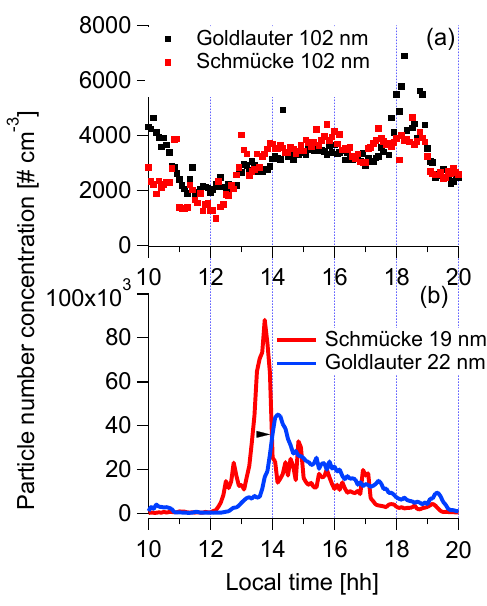
Fig. 5. The time series of particle number concentration during the Fig. 5: The time series of particle number concentration during the NPF event on October 724 NPF event on 12 726